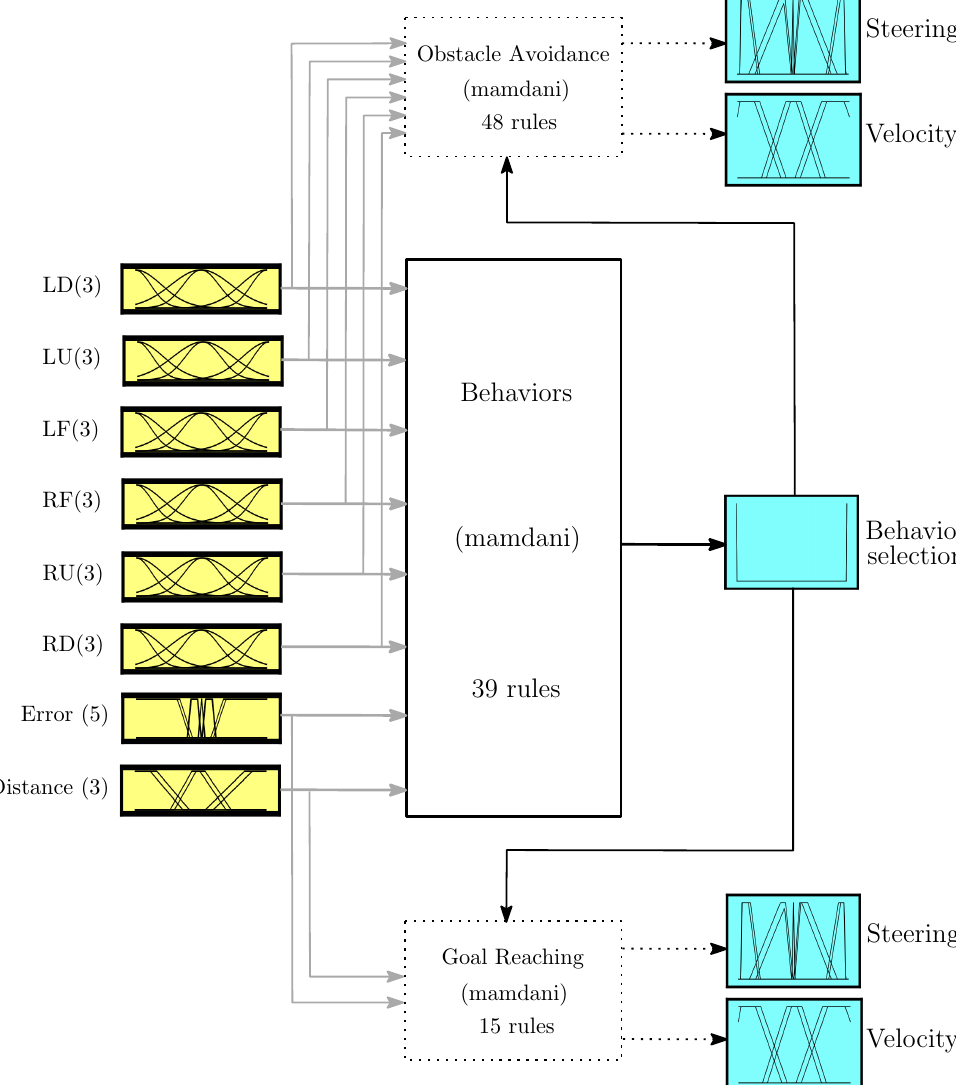
Figure 4. Proposed type-2 fuzzy inference